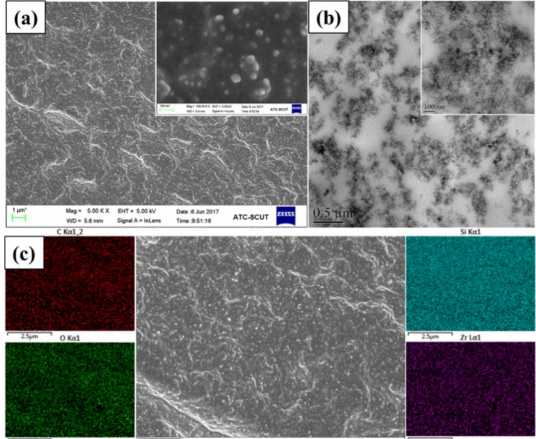
Figure 5. SEM ( a ); TEM ( b ); and SEM-EDS mapping ( c ) images of SR/Zr-POSS-4 nanocomposite.